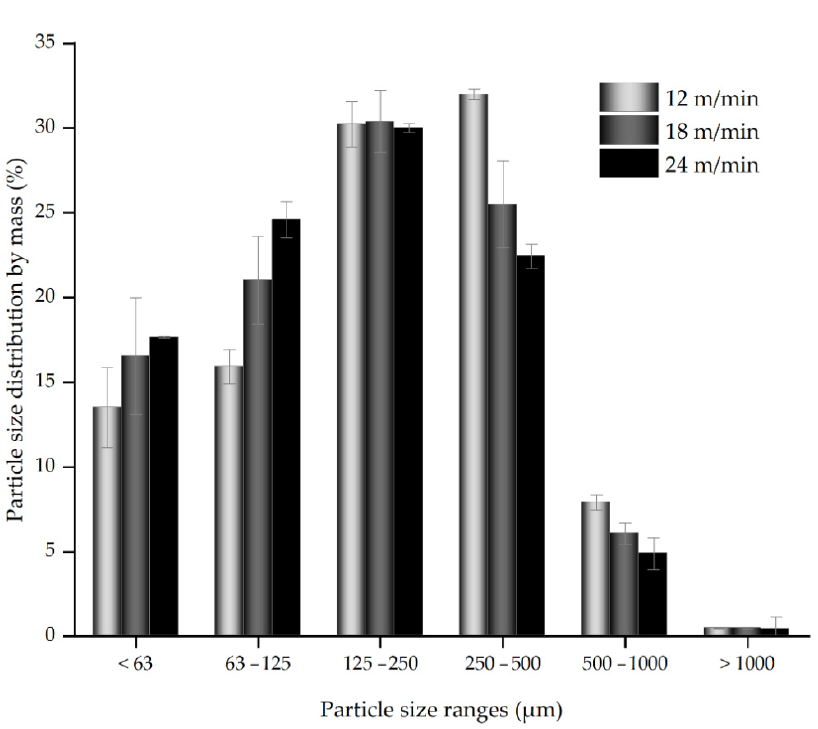
Figure 5. Particle size distribution by mass.